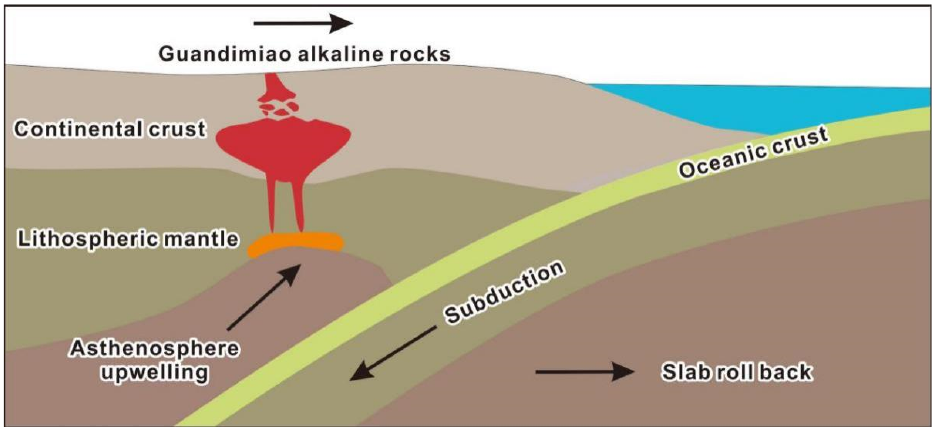
Figure 15. Evolution of the alkaline rocks in the Guandimiao area during the Early Cretaceous [76–78].